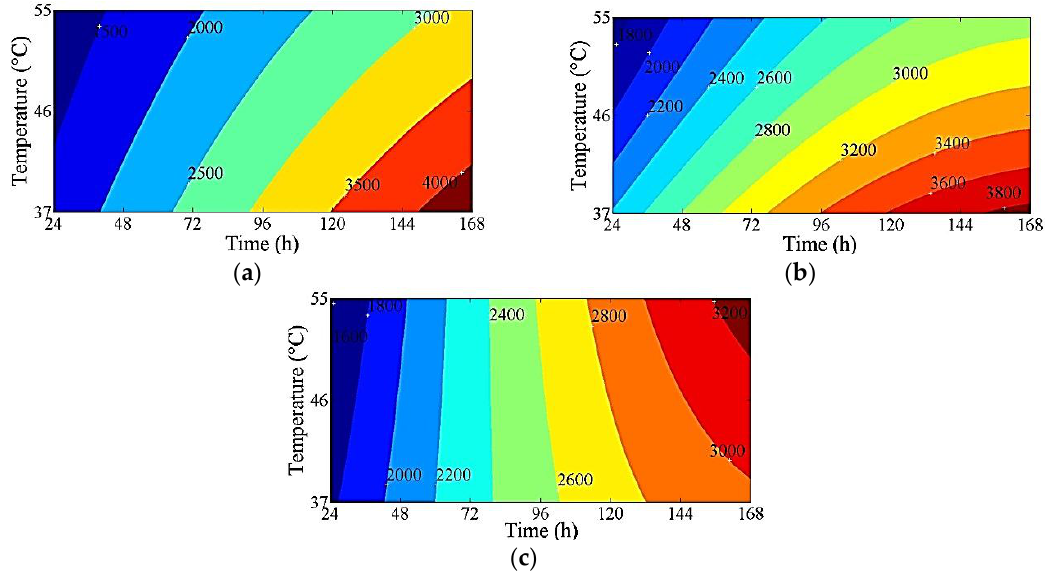
Figure 7. Modeled VFA: ( a ) mechanical pretreatment; ( b ) steam explosion; ( c ) chemical retreatment.